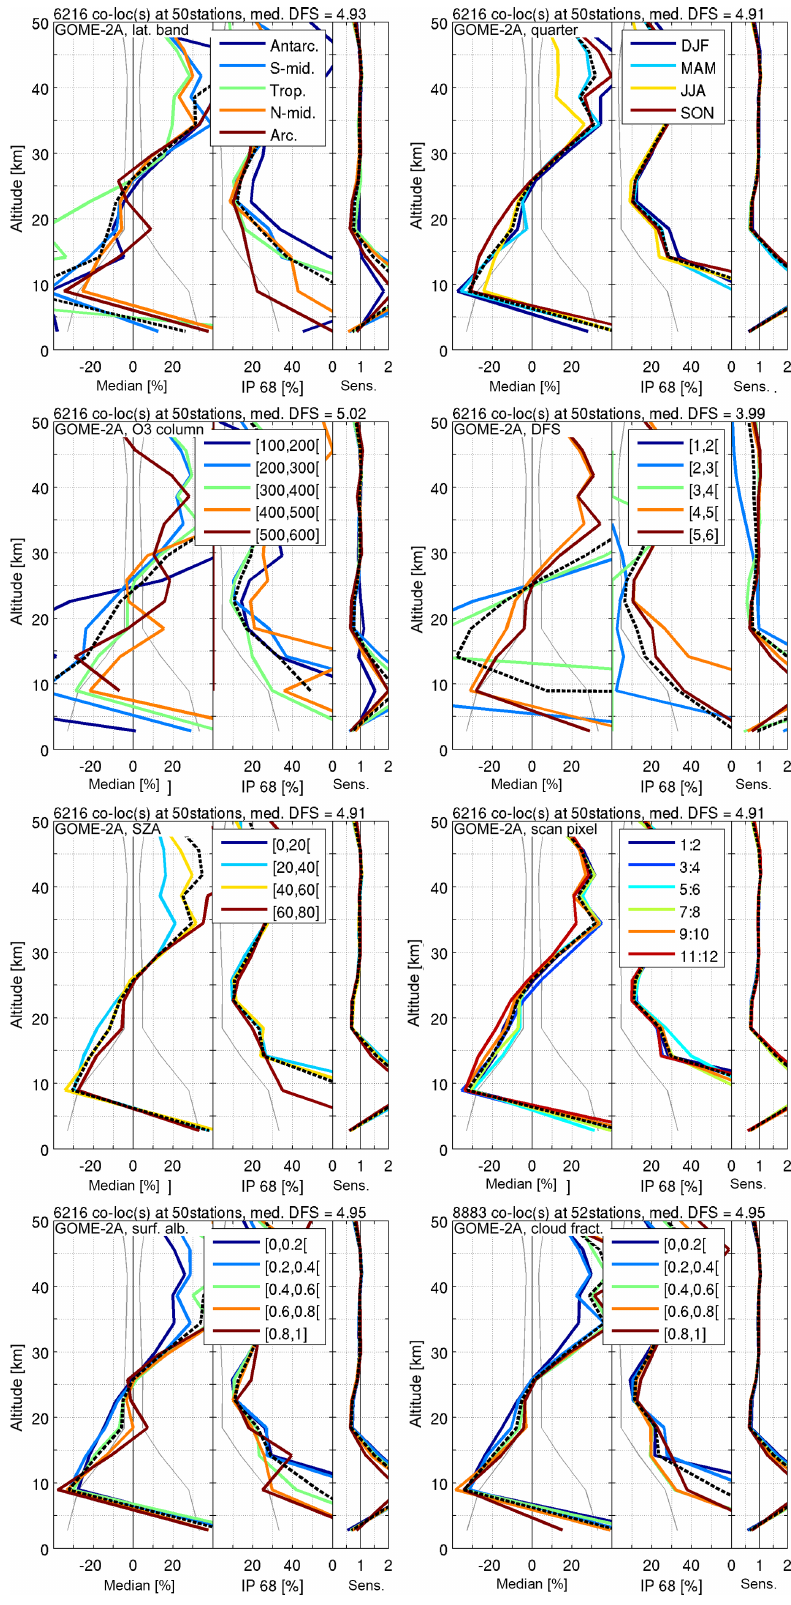
Figure 8. As for Fig. 6, but for RAL 2.14 L2 GOME-2A data